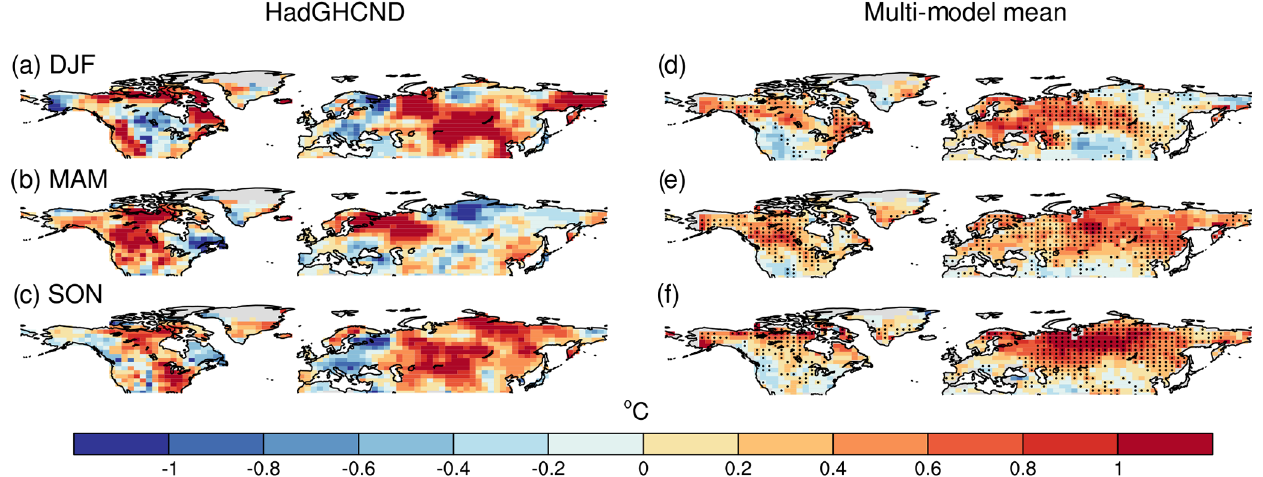
Figure 1. Recent excess changes (1982–2014 to 1950–1981) in cold extremes (seasonal minima – seasonal mean) in HadGHCND (a–c) and the six-member CMIP5 multi-model mean (d–f) for boreal winter (a, d) , spring (b, e) and autumn (c, f) . Grey areas represent areas where data are missing in HadGHCND. Stippling in the multi-model mean represents grid cells where both the multi-model mean agrees in sign with HadGHCND and where at least five out of six models agree on the sign of excess